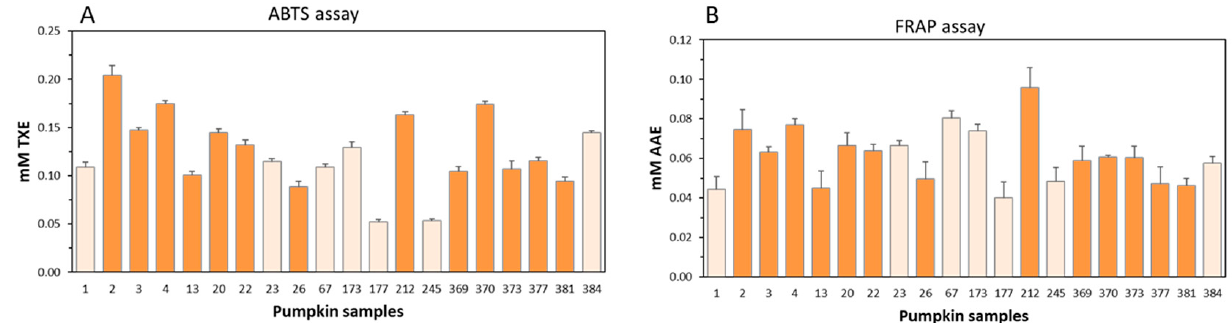
Figure 3. Antioxidant capacity of pumpkin samples. Antioxidant capacity was measured using the ABTS ( A ) and FRAP ( B ) assays. The dark-orange-coloured bars indicate pumpkin samples of Serbian origin, while light-orange-coloured bars indicate pumpkins not originally from Serbia. Error bars represent ± SD of the mean value, n = 3 independent experiments in which each sample was analysed in duplicate. TXE = Trolox equivalents; AAE = ascorbic acid equivalents.